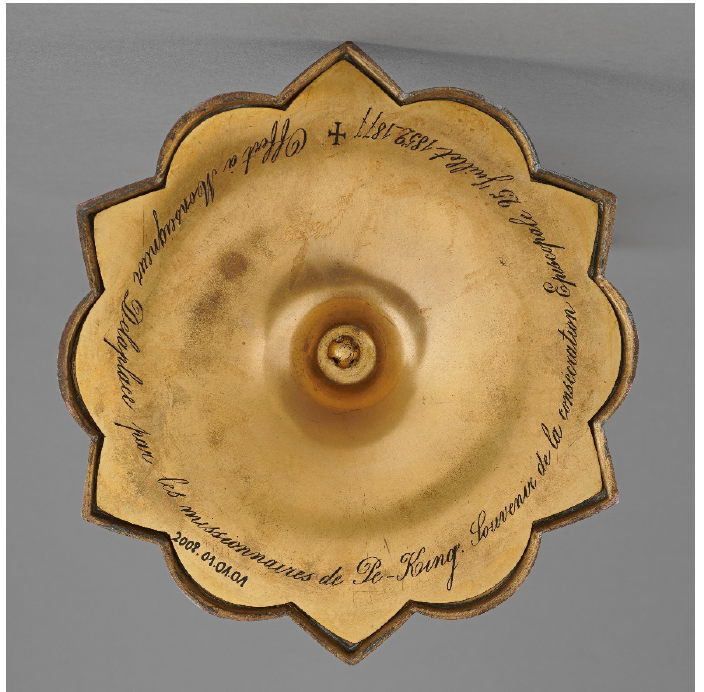
Figure 5. Chalice (detail under the base) of Figure 3. Photo: Conseil départemental de l’Orne/Thierry Ollivier.